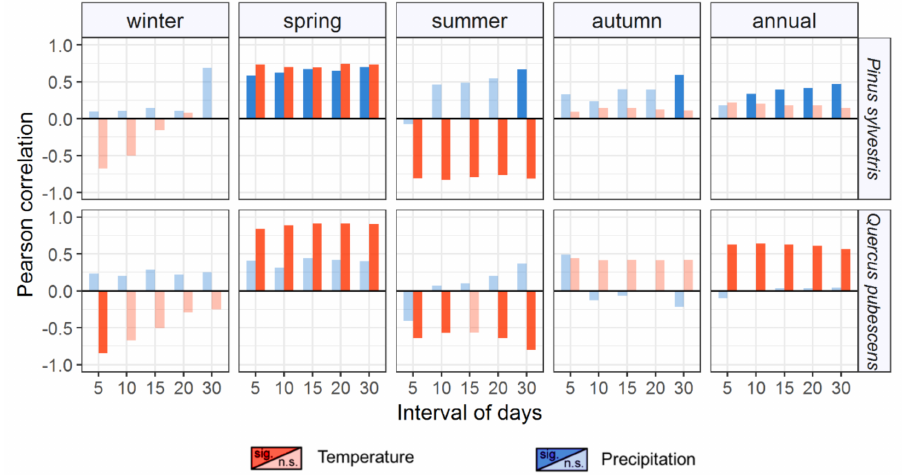
Figure 4. Pearson correlation coefficients between daily climatic variables (mean temperature and total precipitation) and intra-annual radial increment of Scots pine and pubescent oak. Correlations were obtained for the four consecutive years (1997–2000). Climatic variables were averaged (mean temperature) or summed up (precipitation) for 5, 10, 15, 20 and 30 days before the sampling date. Significance at p < 0.05